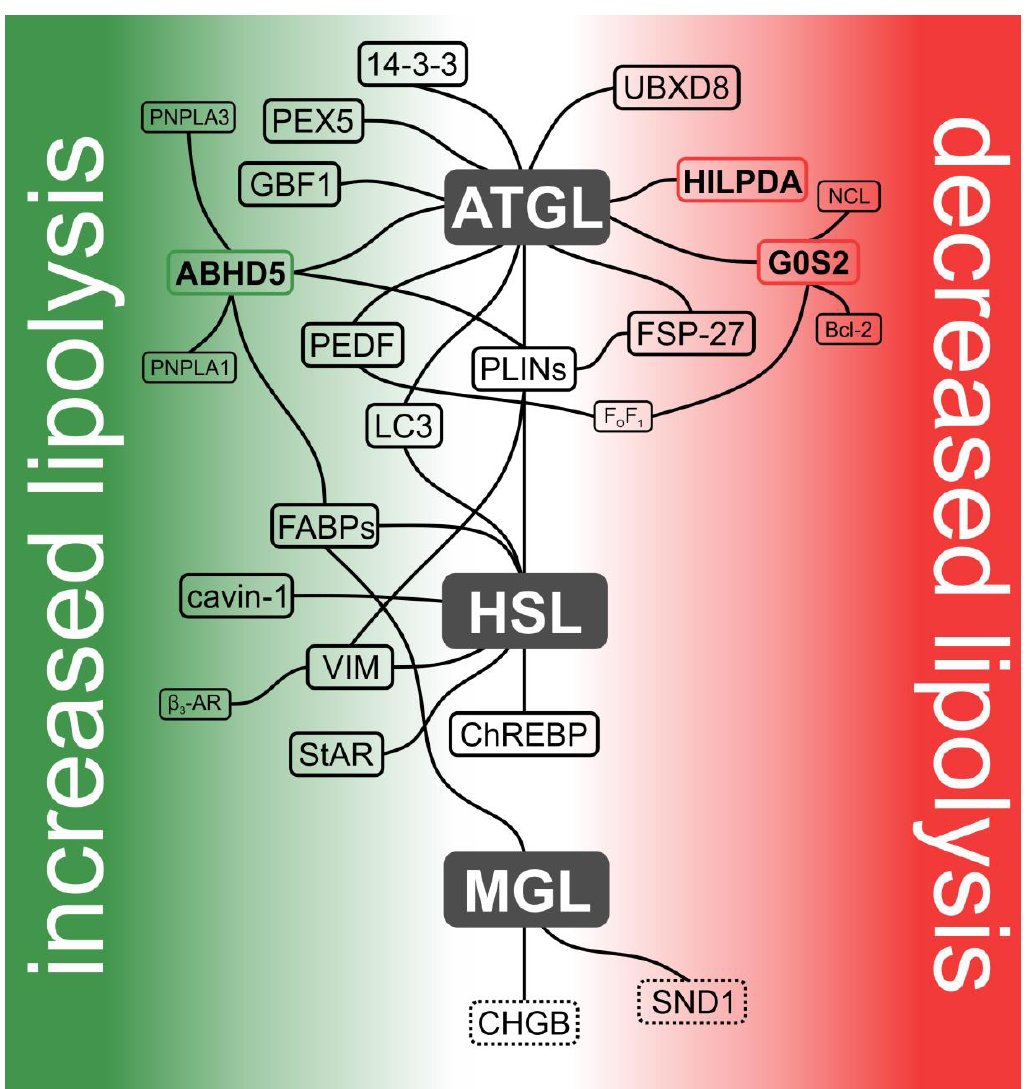
Figure 2. Current model of the lipolysome. Hydrolysis of intracellular TAGs is catalyzed by the sequential action of ATGL, HSL, and MGL. Together with their protein interaction partners, these lipases form a dynamic protein assembly designated as the lipolysome. Interaction partners that activate enzyme activities are depicted in the green area, while those that inhibit enzyme activities are shown in the red area. Proteins directly affecting enzyme activity are highlighted in bold and in colored boxes accordingly (in green: activating and in red: inhibiting). Proteins indirectly affecting lipase activities are shown in black boxes. Putative binding partners are shown in dashed boxes. Lipase-independent interaction partners are shown in smaller font. Interaction partners not affecting lipase activity per se (CHGB (chromogranin B) and carbohydrate response element binding protein (ChREBP)) or having divergent effects on ATGL and HSL (perilipins (PLINs)) are located in the center.